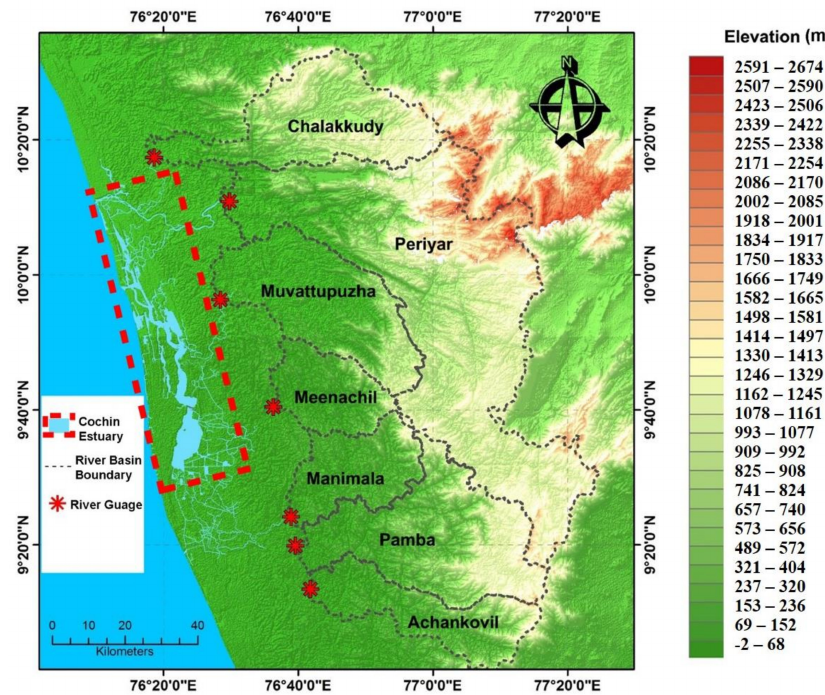
Figure 2. Study region (red box) encompassing the Digital Elevation Model map (Shuttle Radar Topography Mission, 90 m resolution) and Central Water Commission river gauge stations (red dots).